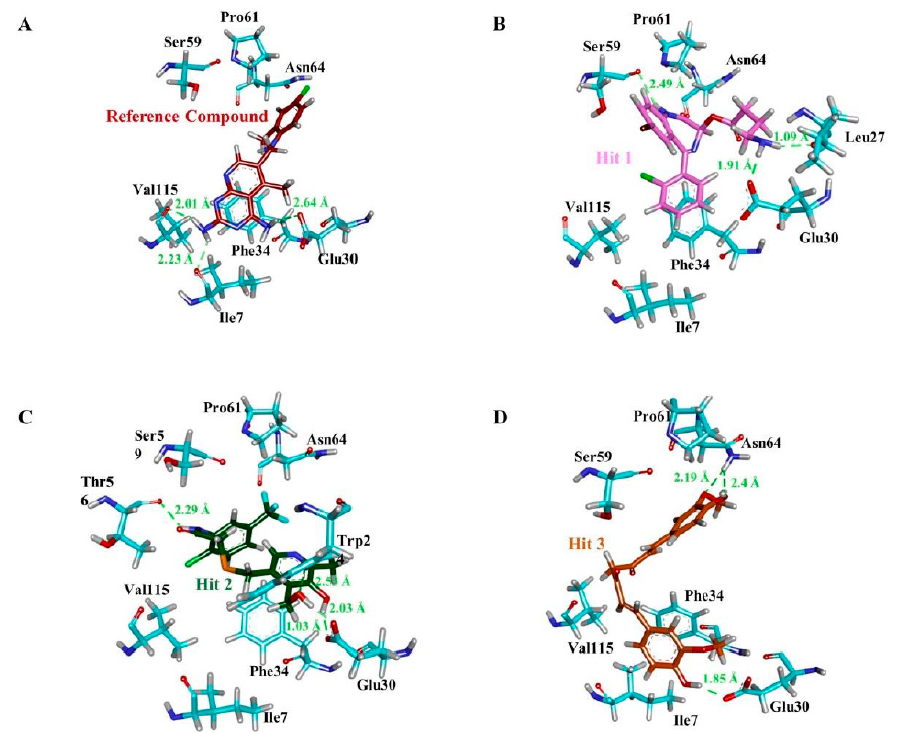
Figure 8. The reference compound and the three hit compounds occupied the active site of hDHFR. All the compounds in their representative structures were superimposed (left) and enlarged (right). 3D structure of hDHFR is shown in light grey color. Red, magenta, green, and orange colors represent the reference compound, Hit1, Hit2, and Hit3, respectively.